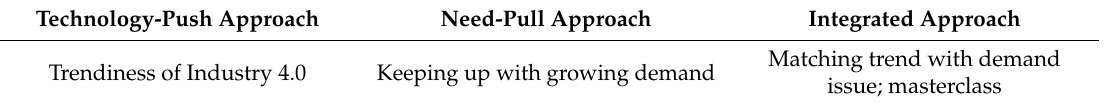
Table 10. Summary of the adoption drivers for Van Raam Rijwielen.